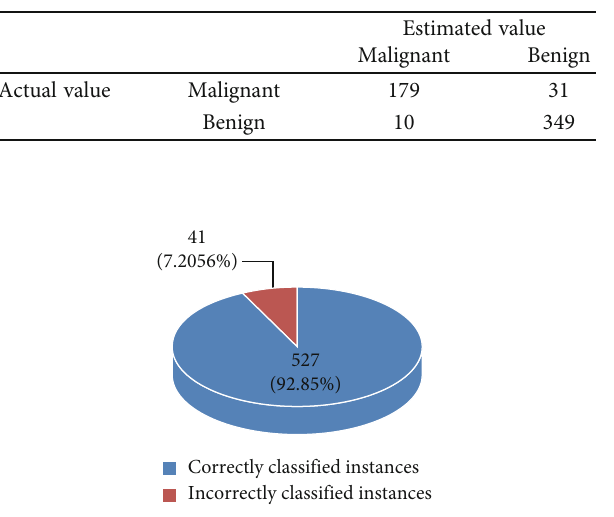
Table 7: Complexity matrix of the K -means technique.